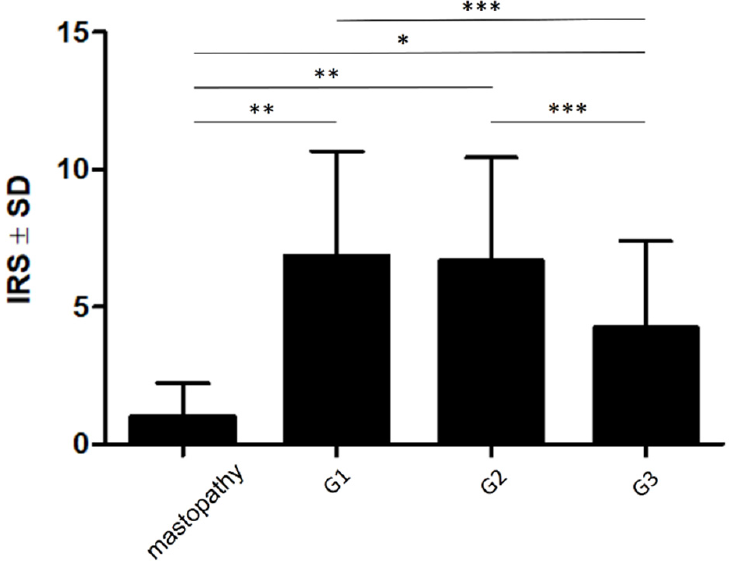
Figure 2. Cytoplasmic expression of nucleobindin-2 in mastopathy in relation to IDC presenting particular malignancy grades. Data presented as the mean ± standard deviation (SD). * p < 0.05; ** p < 0.01; *** p <